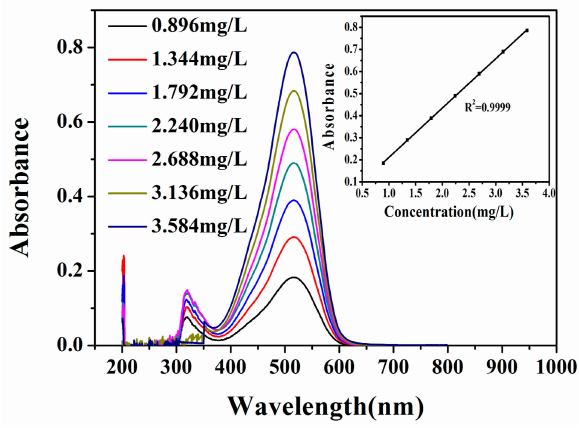
Figure 4. Calibration data for 1-NAP in solution by UV-VIS absorption after addition of sulfonic